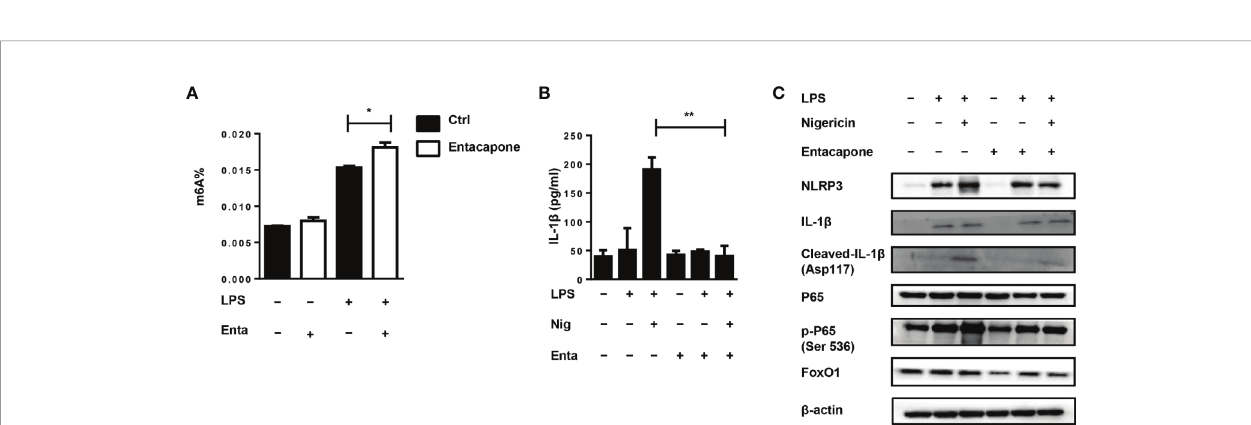
FIGURE 8 | Blockade of FTO inhibits NLRP3 in fl ammasome-mediated IL-1 b secretion. (A) BMDMs were pre-incubated with or without entacapone 1 h before LPS stimulation. Then the total RNA was collected after 12 h and the mRNA m 6 A levels were detected by colorimetric ELISA assay. (B) BMDMs were pre-incubated with or without entacapone. Then, LPS and nigericin were added to activate the NLRP3 in fl ammasome. The concentration of IL-1 b in culture medium was measured by ELISA. (C) Immunoblot analysis of NLRP3, IL-1 b , Cleaved-IL-1 b (Asp117), FoxO1, P65 and phospho-P65 (Ser 536) expression. b -actin was used as a loading control. Data are shown as mean ± SEM; *P < 0.05; **P < 0.01 (two-tailed unpaired